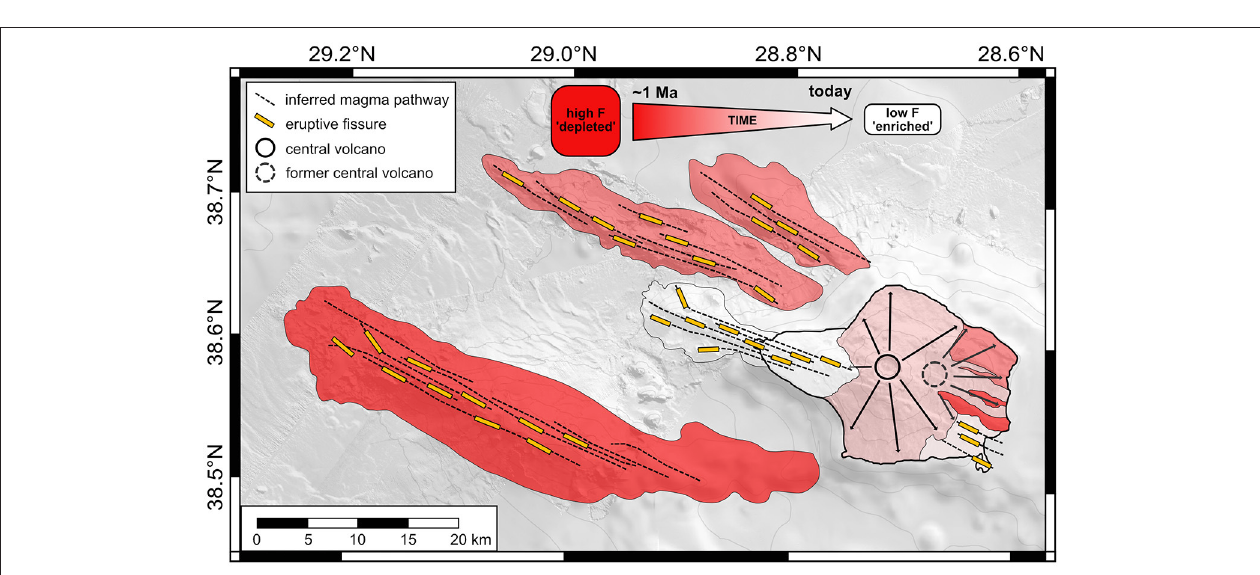
FIGURE 11 | Schematic illustration of the progressive spatial evolution of the conditions of melting and structural features. Note that older lavas with less enriched mantle source compositions at higher degrees of partial melting (F) (dark red colors, large box) occur more widespread than the younger lavas, having more enriched mantle source compositions at lower melting degrees (bright red to white colors, small box). The recent mafic and intermediate volcanic activity on Faial occurs exclusively along narrow rift zones, whereas the older volcanic activity is characterized by both volcanic rift zones and central volcanic edifices. Not to